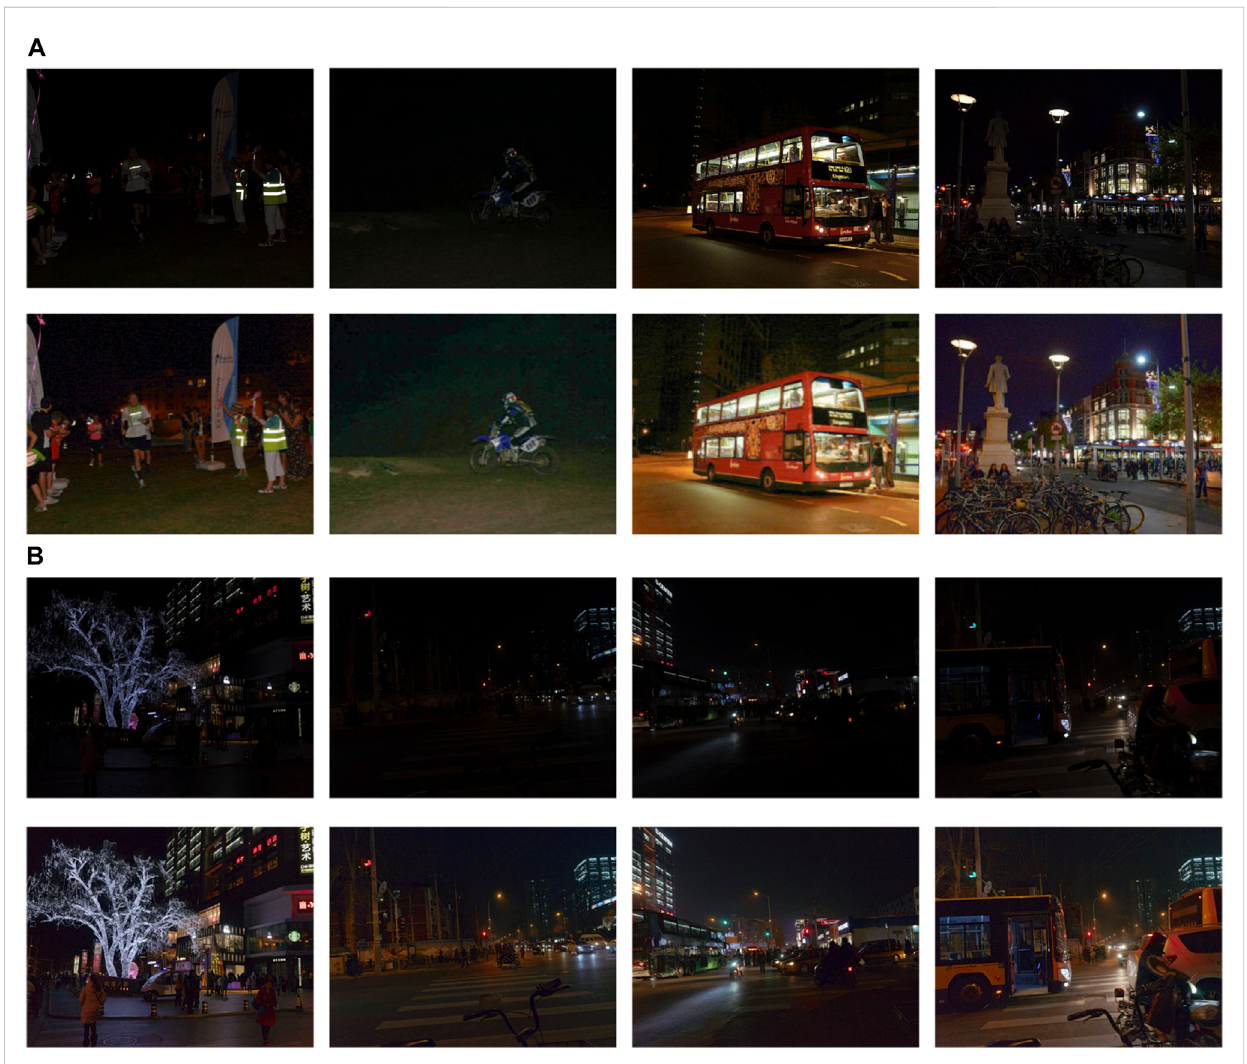
FIGURE 7 Evaluation ofgeneralization capability onreal-worlddatasets, i.e., (A) Exclusive Dark dataset and (B) DARK FACE dataset. Inboth (A,B) panels,the 1st row indicates input LL images, and the 2nd row shows enhanced results by the proposed framework. Our method has superior generalization capability to extremely low-illumination real-world